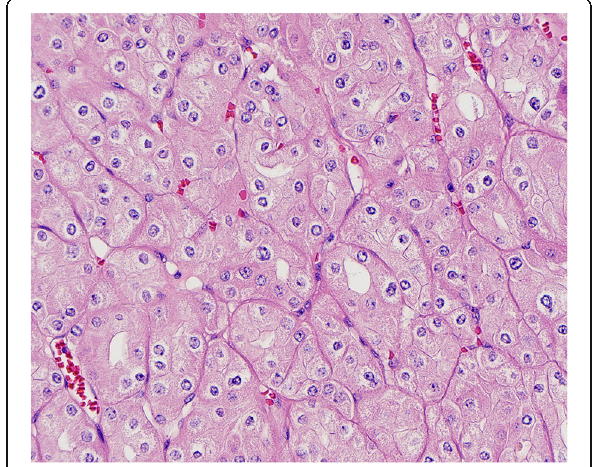
Fig. 2 Multifocal oncocytoma-like tumor associated with oncocytosis. Tumor cells are arranged in nests and acini, and perinuclear halos are seen